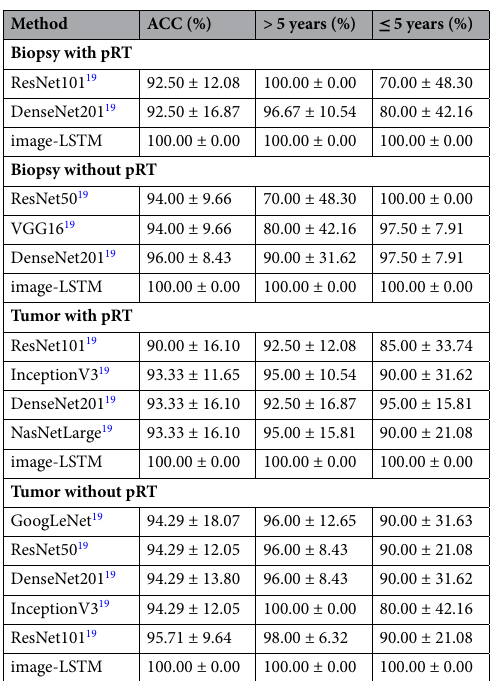
Table 2. Prediction and prognosis of DNp73: IHC rectal-cancer